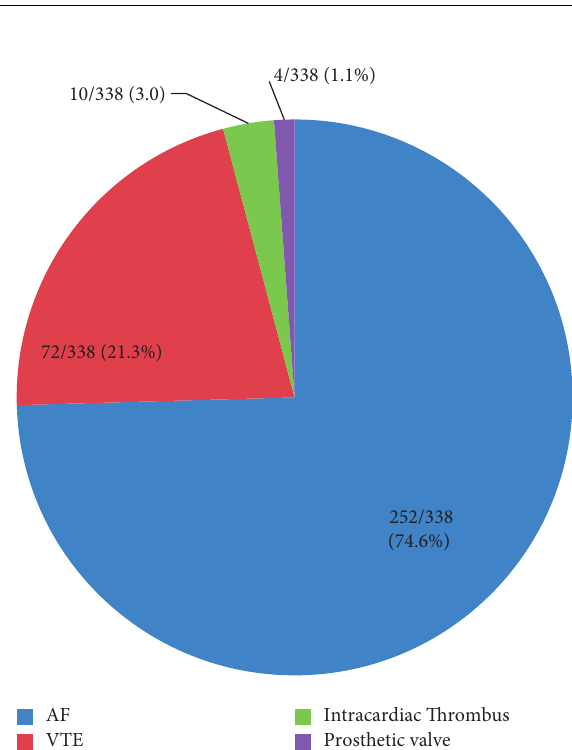
Figure 1: Pie chart showing number (percentage) of indications for warfarin therapy. AF, atrial fibrillation; VTE, venous